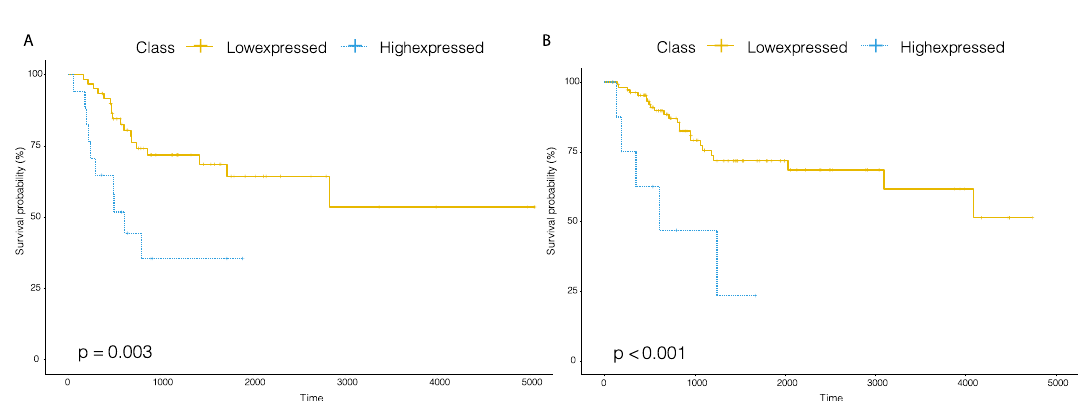
Figure 4. Kaplan–Meier curves of overall survival for patients treated with cis-platin at low or high expressed classes stratified by miR-483 in the BLCA or